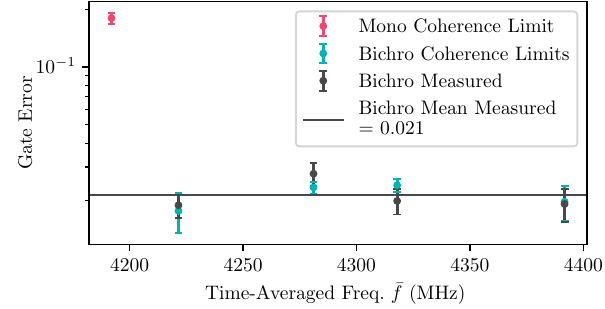
Time-Averaged Freq. ¯ f FIG. 7. The measured gate error and coherence-limited error for four bichromatic, k = − 4 CZ 02 gates between qubits 1 and 2 (ref. Table I), plotted against the time-averaged frequency of qubit 1 during modulation. The calculated coherence limit for the monochromatic k = − 4 CZ 02 gate is included for comparison. Each gate is operated at a dynamical sweet spot, and each mea- sured point is the weighted mean of six or more measurements of gate error and coherence-limited error. Error bars represent the standard deviations of these distributions. Gate errors are measured via interleaved randomized benchmarking, and the bichromatic coherence limits are calculated by directly measur- ing coherence times under each bichromatic modulation. The monochromatic coherence limit is calculated using the coher- ence times in Table I with a best-case assumption of 100% sweet spot resurgence (demonstrated in Fig. 3 for this qubit) dur- ing modulation at this gate operating point. Even under these assumptions for the monochromatic gate, there is an order-of- magnitude difference between bichromatic and monochromatic coherence limits resulting from the 7–10 times shorter bichro- matic gate times. Details about these operating points can be found in Table